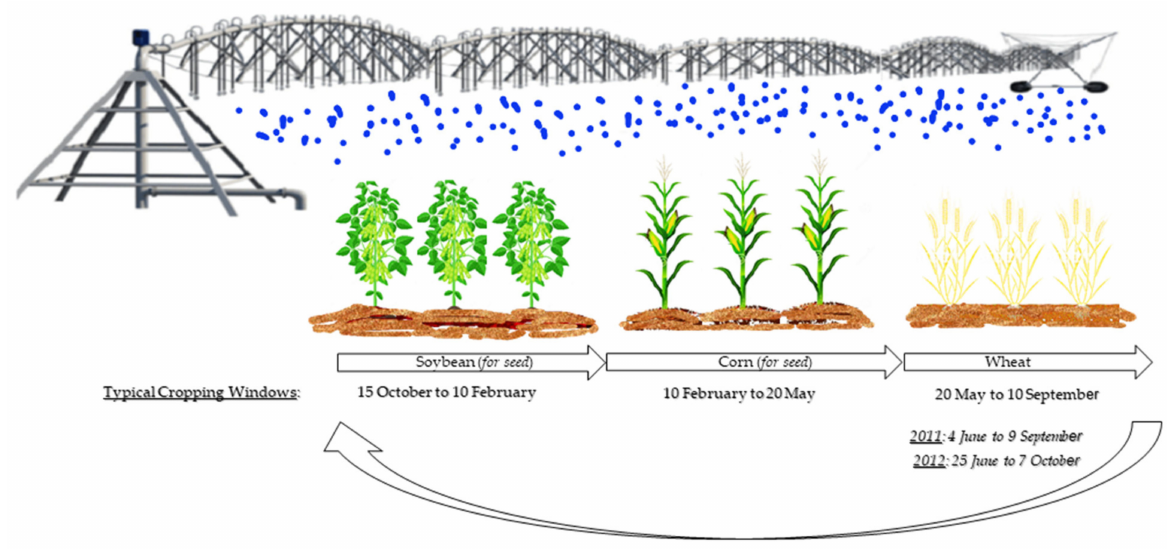
Figure 1. Typical annual triple-crop rotation for irrigated crops in Cerrado,